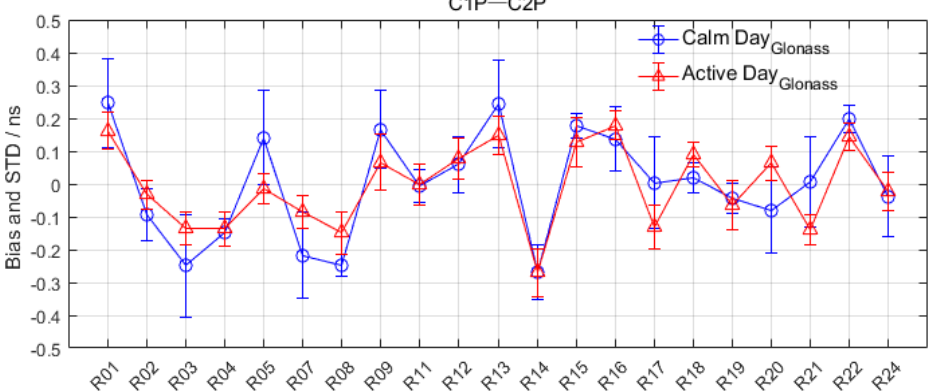
Figure 14. Comparison results between DCB and CODE products of GLONASS satellite.